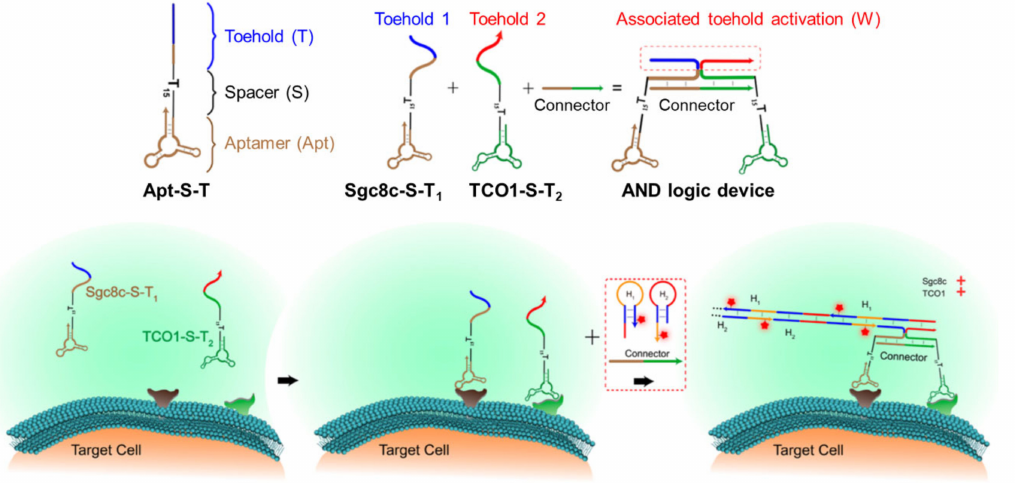
Figure 9. Scheme of a protein sensor based on DNA displacement and a catalytic DNA circuit for signal amplification. Adapted with permission from J. Am. Chem. Soc. 2013, 135, 2443–2446, doi:10.1021/ja311990w. https://pubs.acs.org/doi/full/10.1021/ja311990w (accessed on 31 January 2021). Copyright (2013) American Chemical Society [83].